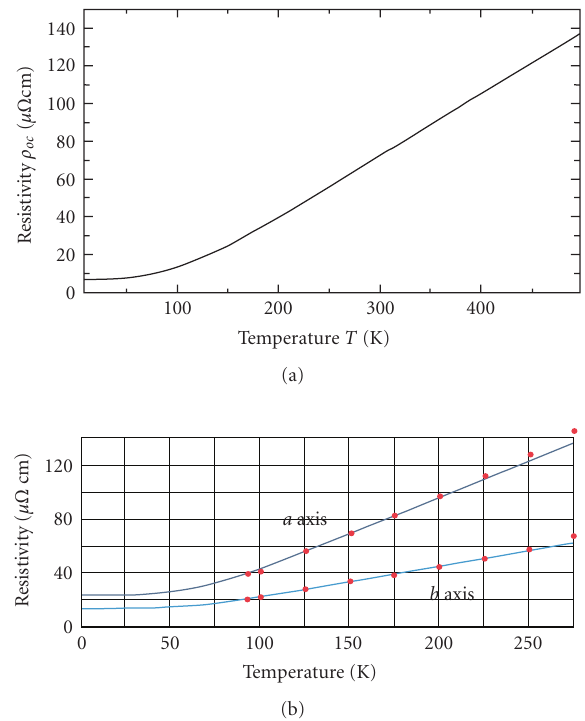
Figure 12: (a) Calculated resistivity ρ ( T ) for the EPI spectral ( ω ) F ( ω ) in [118]. (b) Measured resistivity in a ( x )- function α 2 tr and b ( y )-crystal direction of YBCO [119] and calculated Bloch- Gr¨uneisen curve (points) for λ ep = 1